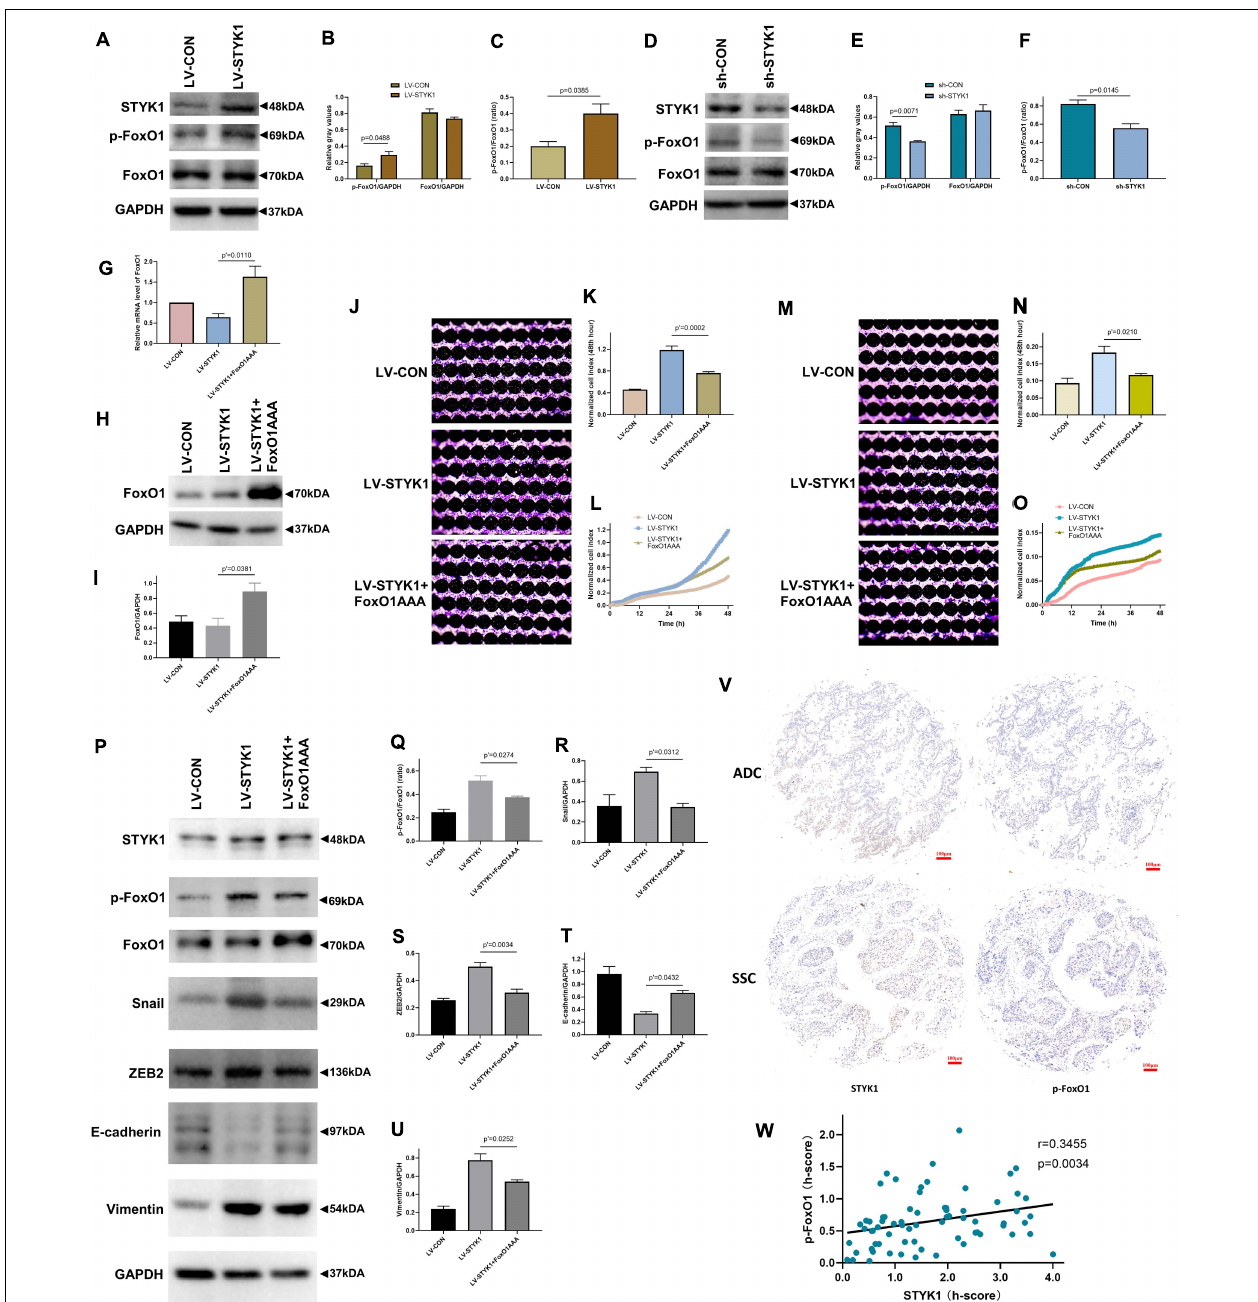
FIGURE 5 | STYK1 activates migration, invasion, and EMT in NSCLC cells by repressing FoxO1. (A–C) Immunoblots and semiquantitative analysis of p-FoxO1 and FoxO1 levels, as well as the p-FoxO1/FoxO1 ratio after lentiviral STYK1 overexpression; P = 0.0488 and P = 0.0385, Student’s t -test. (D–F) Changes in p-FoxO1 and FoxO1 levels, as well as in the p-FoxO1/FoxO1 ratio after transfection with shRNA targeting STYK1 ; P = 0.0071 and P = 0.0145, Student’s t -test. (G–I) Confirmation of lentiviral expression of FoxO1AAA by RT-qPCR and western blot; P (cid:48) = 0.0110 and P (cid:48) = 0.0381, ANOVA followed by the Tukey’s multiple comparisons test. (J–L) Cell migration ability of SW900 cells after lentiviral overexpression of STYK1 and FoxO1AAA, evaluated by RTCA and crystal violet staining; P (cid:48) = 0.0002, ANOVA followed by the Tukey’s multiple comparisons test. (M–O) Cell invasion potential after co-transduction with lentiviruses; P (cid:48) = 0.0210, ANOVA followed by the Tukey’s multiple comparisons test. (P–U) Representative immunoblots and semiquantitative analysis of the p-FoxO1/FoxO1 ratio and EMT biomarkers after co-transduction with lentiviruses; P (cid:48) = 0.0274, P (cid:48) = 0.0312, P (cid:48) = 0.0034, P (cid:48) = 0.0432 and P (cid:48) = 0.0252, ANOVA followed by the Tukey’s multiple comparisons test. (V) Typical IHC of STYK1 and p-FoxO1 protein expression in NSCLC samples ( n = 70). (W) Correlation between STYK1 and p-FoxO1 expression levels in NSCLC samples; P = 0.0034, Spearman correlation analysis; Spearman r = 0.3455. LV-CON, control SW900 cells; LV-STYK1, SW900 cells overexpressing STYK1; sh-CON, control Calu-1 cells; sh-STYK1, Calu-1 cells transfected with shRNA plasmids targeting STYK1 ; LV-STYK1 + FoxO1AAA, SW900 cells with lentiviral overexpression of both STYK1 and FoxO1AAA. ADC, adenocarcinoma; SCC, squamous cell carcinoma.